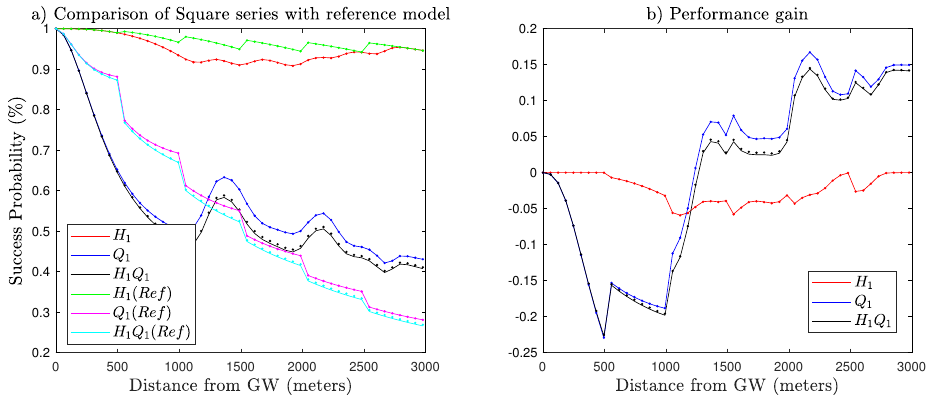
Figure 8. ( a ) Performance comparison of square series with the reference model for ¯ N = 500. ( b ) Performance gain (success probability of proposed model − success probability of reference model). The proposed SF allocation approach sacrifices Q 1 , H 1 Q 1 for the lower SFs but achieves greater performance for the higher